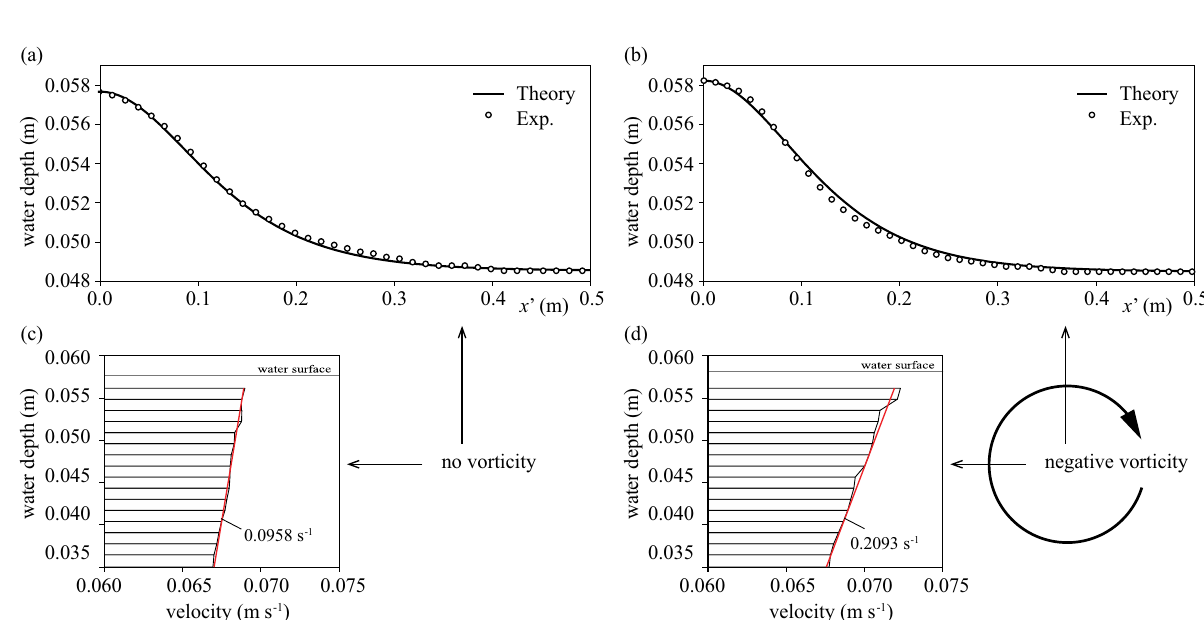
Figure 2. Wave profile and horizontal velocity. ( a ) Wave profile of Lab1 with no vorticity. ( b ) Wave profile of Lab2 with vorticity. Solid lines indicate the Fenton’s solution, and circles indicate the water depth by laboratory experiments. ( c ) Vertical profile of the horizontal velocity at the crest of Lab1 with no vorticity. ( d ) Vertical profile of the horizontal velocity of Lab2 with